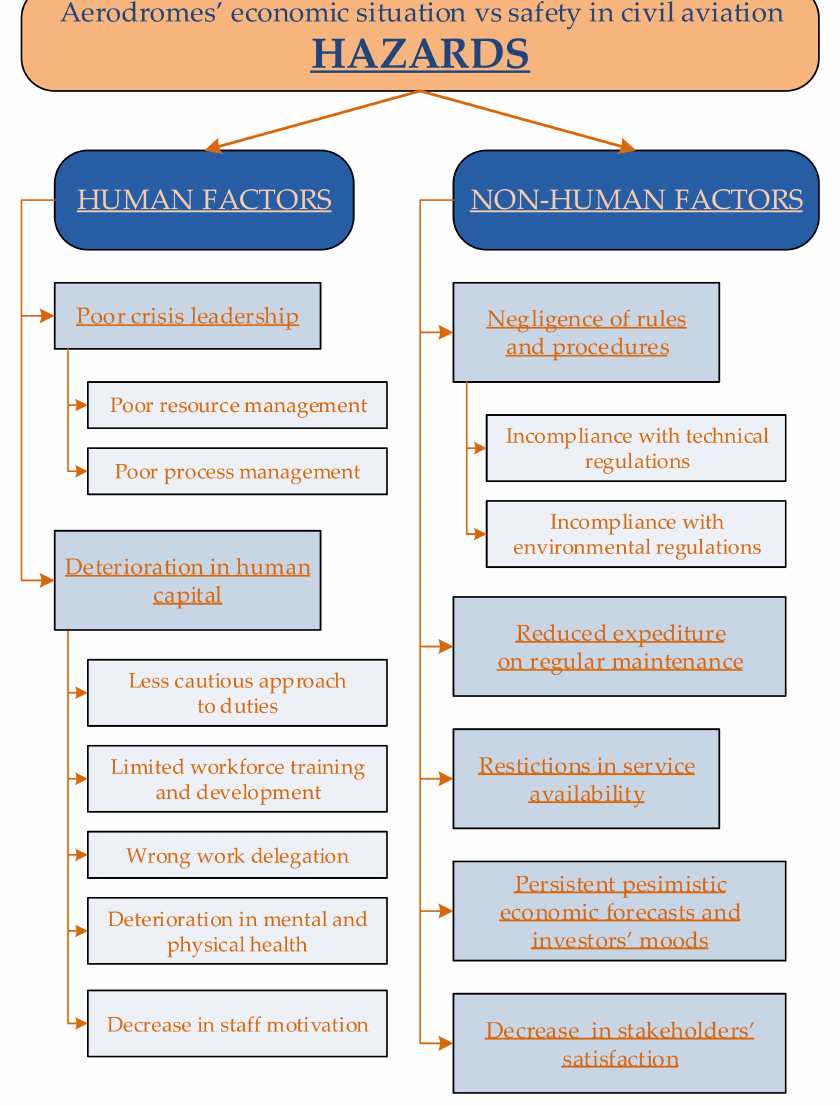
Figure 3. Identified hazards concerning the influence of aerodromes’ difficult economic situation on safety in civil aviation, own